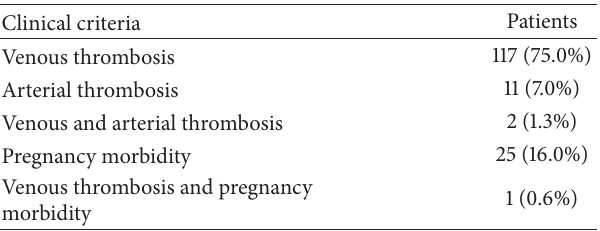
Table 1: Clinical criteria of inclusion in APS patients group and